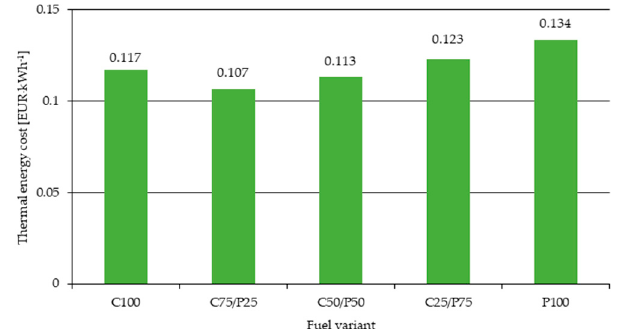
Figure 13. The average cost of producing 1 kWh of heat from the fuels studied under Polish condi- tions.